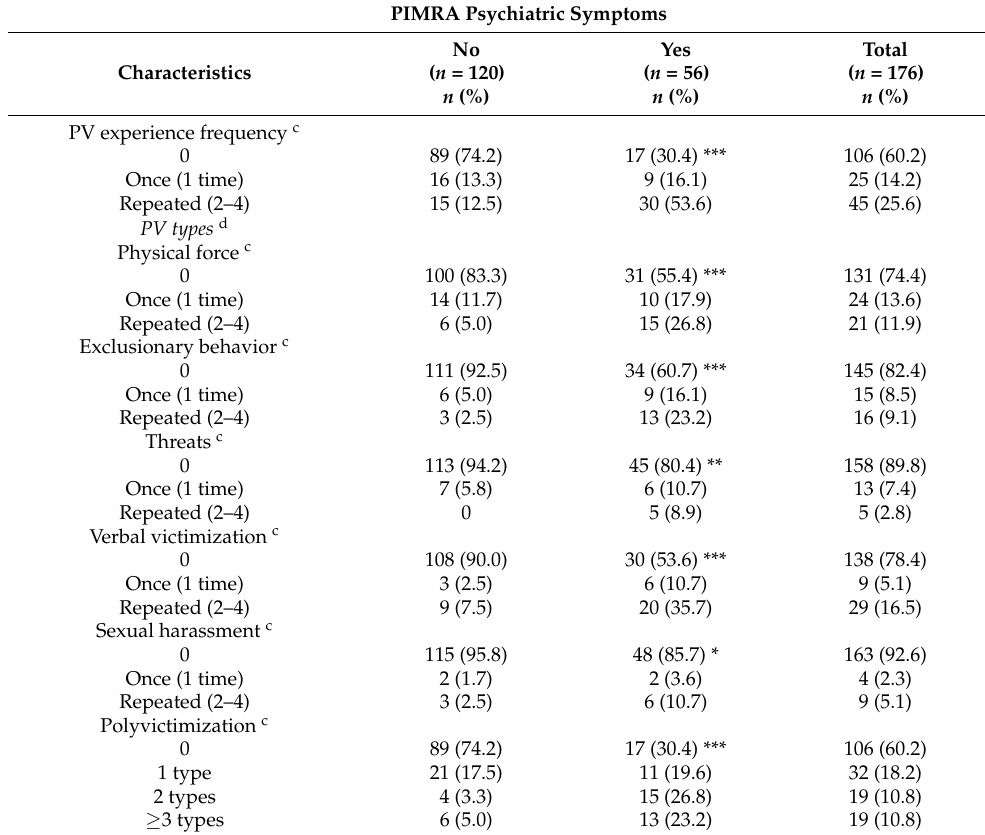
Table 3. Peer victimization experience during 1-year study